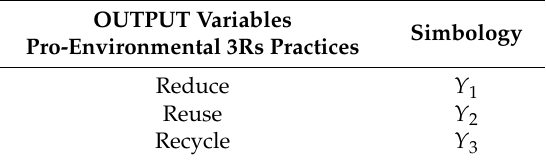
Table 3. Practices associated with the pro-environmental behavior development